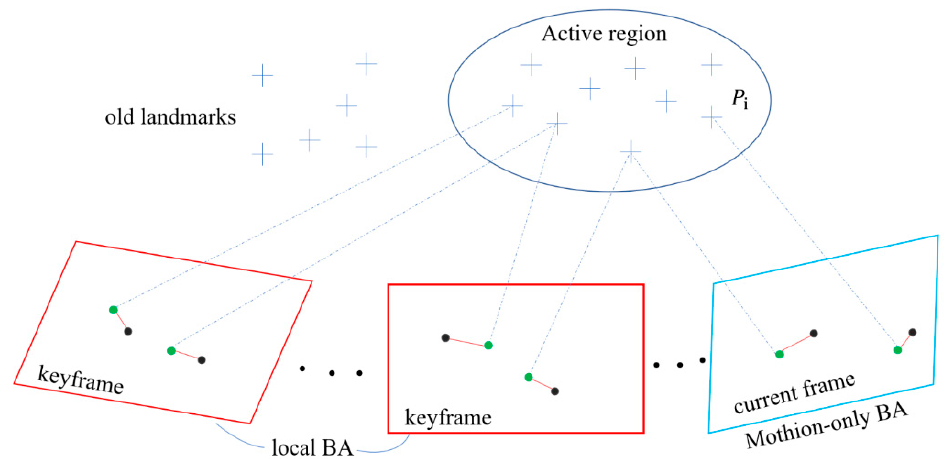
Figure 4. This figure depicts the process of motion-only BA and local BA. The blue rectangle denotes the current frame, the red rectangles denote the keyframe, the crosses denote a sparse set of landmarks, the green dots represent the projection of landmarks π ( · ) , the black dots represent visual measurement Z i ( · ) , and the red segment between green dots and black dots represents reprojection error. Motion-only BA only refines the latest vehicle pose, whereas local BA jointly optimizes keyframes and landmarks in the form of a factor graph. Both operations refer to minimizing the reprojection error.